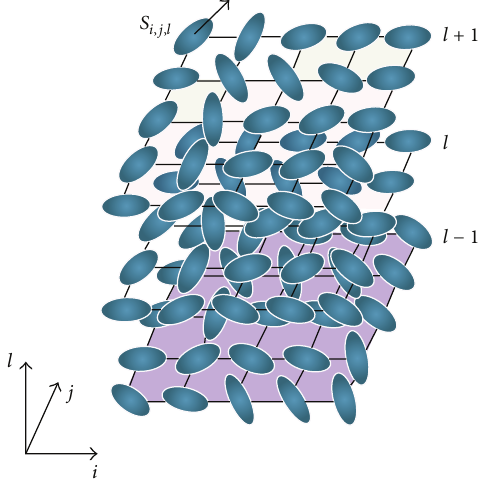
Figure 4: Multilayered model of interacting elastic ellipsoidal